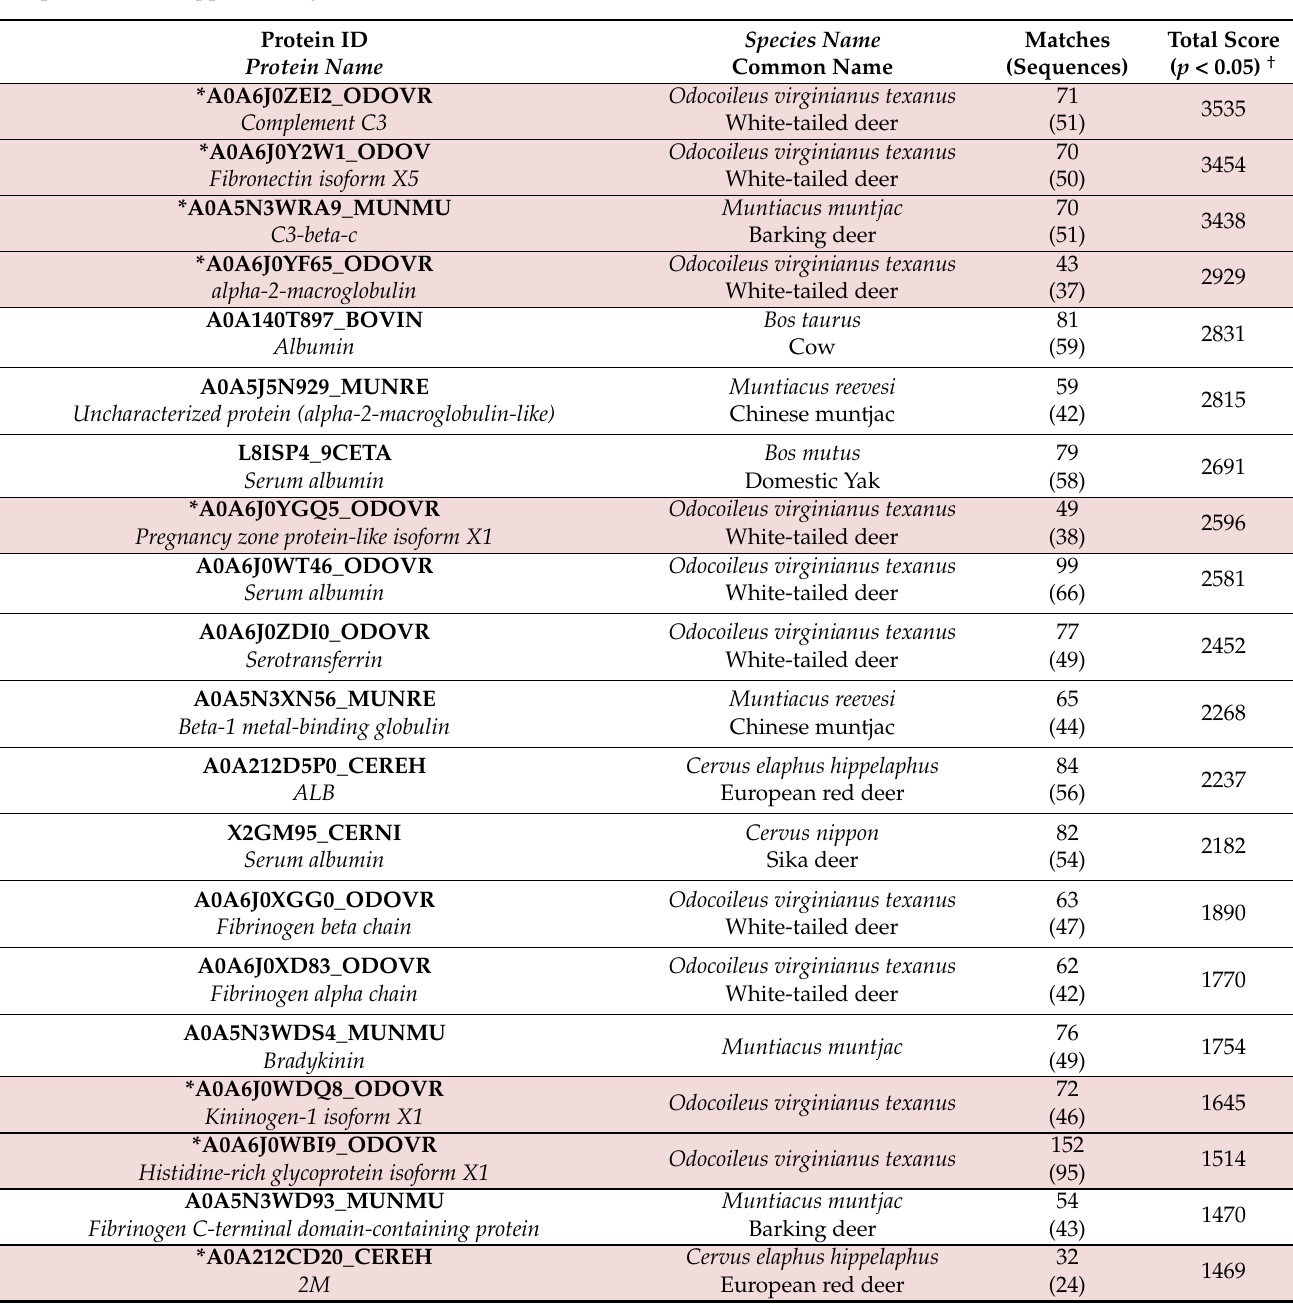
Table 2. Deiminated proteins in whole plasma of reindeer ( Rangifer tarandus ) identified by F95 enrichment and liquid chromatography with tandem mass spectrometry (LC–MS/MS) analysis. Proteins identified only in whole plasma (and not in plasma EVs) are highlighted in pink and with an asterix (*); uncharacterized hits with a secondary hit that was annotated are included and indicated in brackets. Protein ID, protein name, species hit with the Artiodactyla UniProt database, number of matches and total score are included in the table. For full detailed LC–MS/MS data on F95-enriched proteins, see Supplementary Table